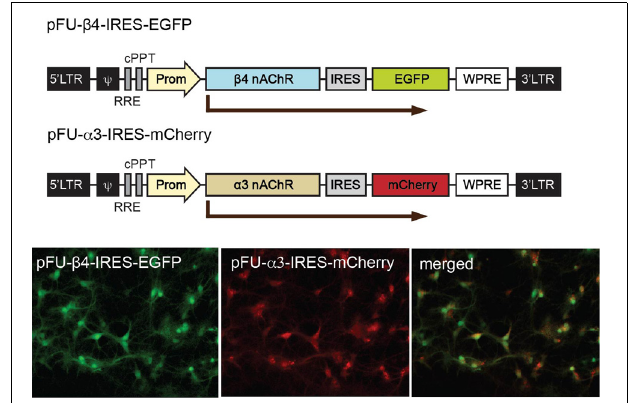
FIGURE 3 | Schematic representation of the viral constructs for expression of α 3 and β 4nAChRs in neurons and for stereotactic injections in the Mhb. Graphic representation of the lentiviral vectors encoding β 4 (pFU- β 4-IRES-EGFP) and α 3 (pFU– α 3-IRES-mCherry). The modules for viral expression are indicated: (cid:3) , packaging sequence; RRE, rev-responsive element; cPPT, central polypurine tract; Prom, human ubiquitin 2 promoter; IRES, internal ribosome entry site sequence; WPRE, woodchuck hepatitis B virus post-transcriptional regulatory element. Photomicrographs of direct fluorescence signal in rat hippocampal neurons transduced with the indicated β 4 and α 3